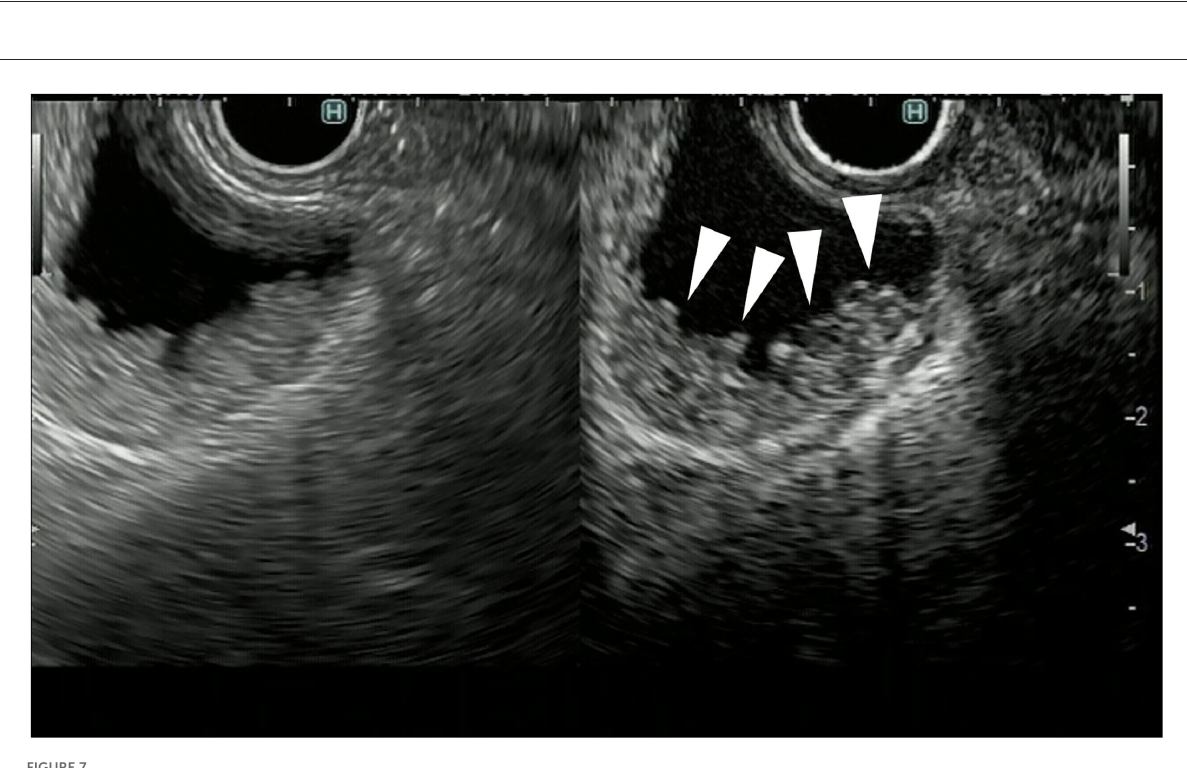
FIGURE7 Contrast-enhanced harmonic EUS for gallbladder wall thickening gallbladder wall thickening (arrowhead) demonstrates heterogeneous